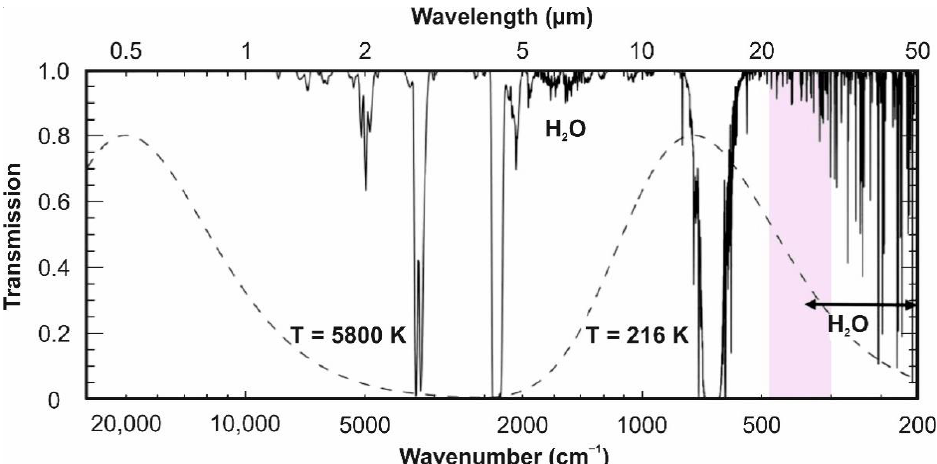
Figure 3. Synthetic infrared transmission spectrum for the atmosphere of Mars (clear of dust and aerosols), calculated assuming temperature structure and composition from the COSPAR Reference Atmosphere for Mars. The dashed lines show blackbody emission curves for temperatures of 5800 and 216 K, representative of the Sun and the Martian surface, respectively. Note the excellent atmospheric transmission in our target range of 21–30 µ m (pink field). Modified from [33]. © IOP Publishing. Reproduced with permission. All rights reserved .